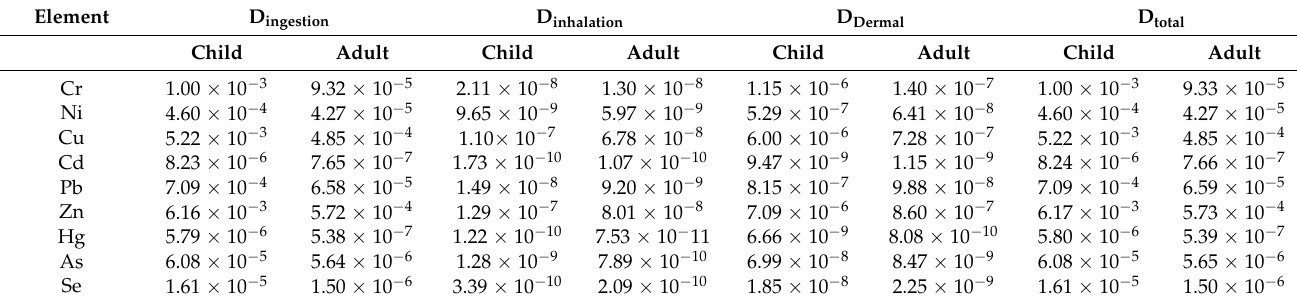
Table 4. Exposure to heavy metals in SHD through the different exposure